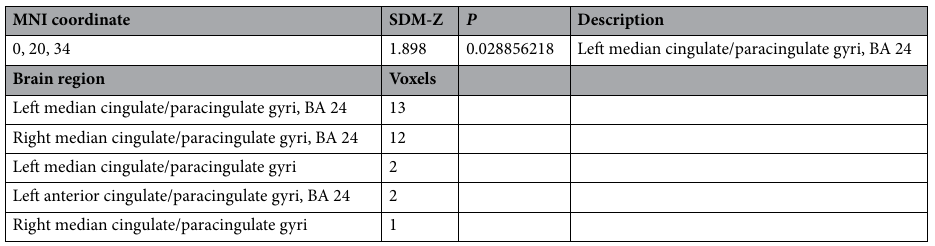
Table 2. Significant Clusters Identified from Meta-analysis.